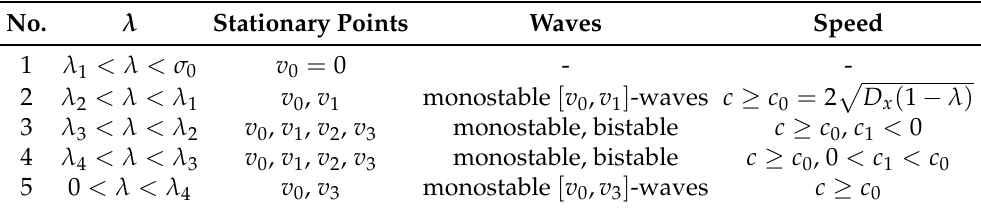
Table 1. Four critical values λ 1 , λ 2 , λ 3 , λ 4 , determine the intervals of λ with different stationary points, waves, and their